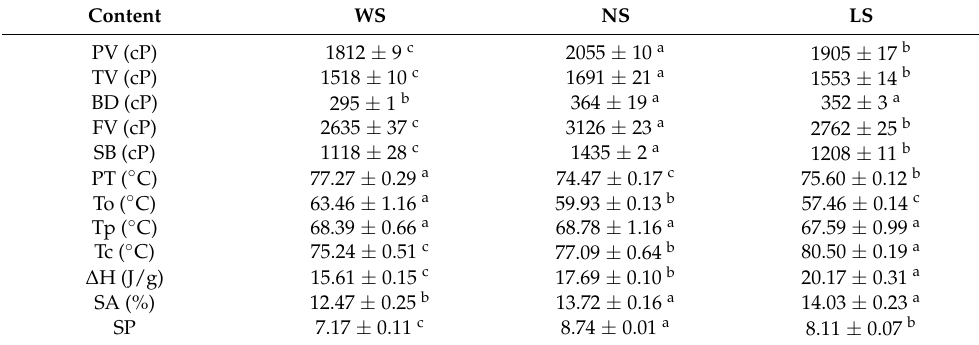
Table 4. Pasting properties, thermal properties, swelling power, and solubility of starch samples extracted by different